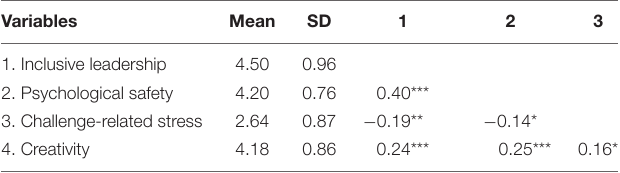
TABLE 2 | Means, standard deviations, and correlations.